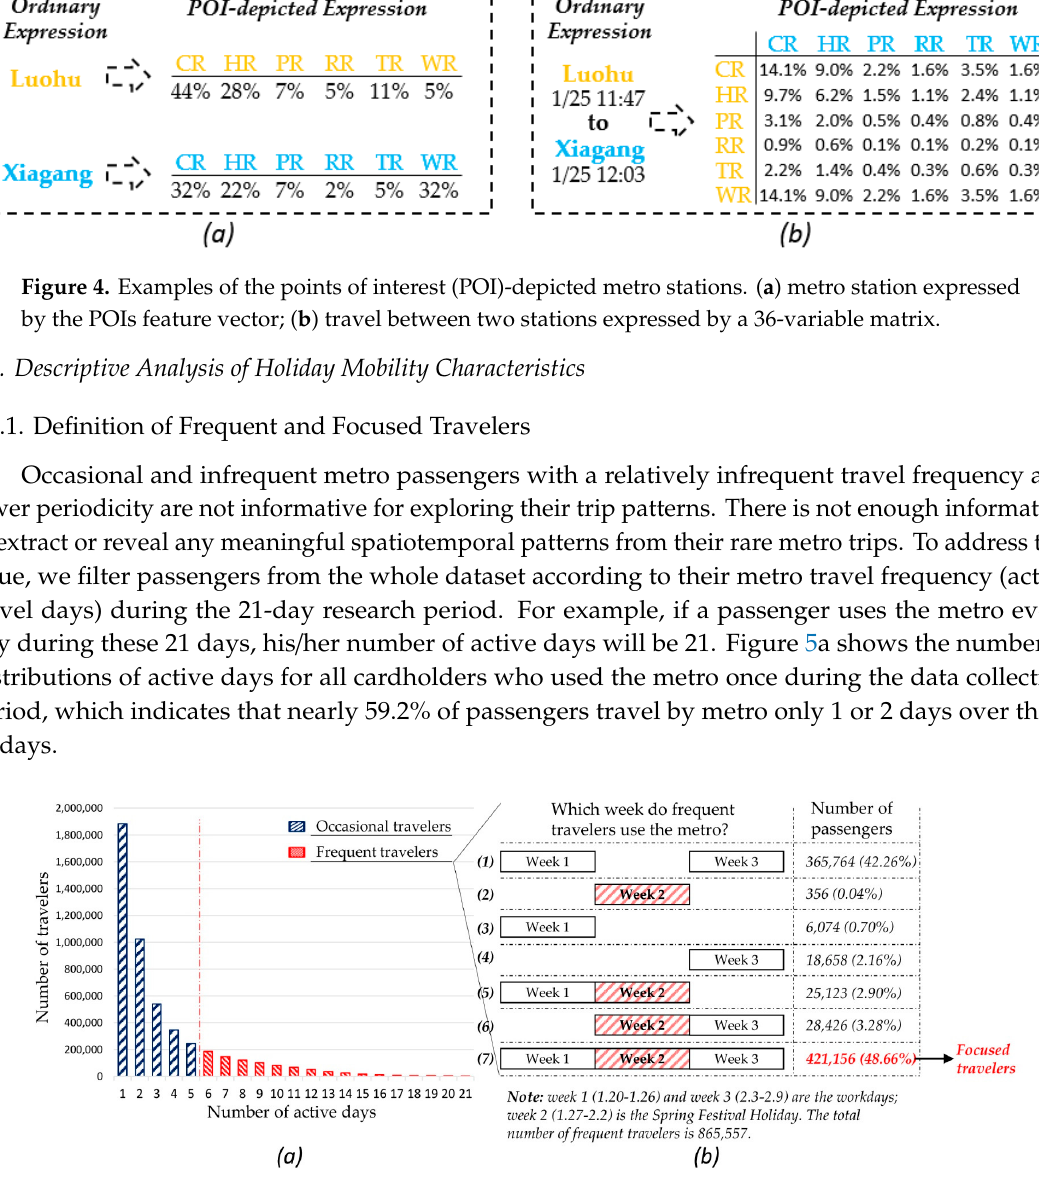
Figure 5. Distribution of active days and 7 types of frequent travelers. ( a ) Filter frequent travelers from all metro passengers; ( b ) among the selected frequent travelers, further filter the focused travelers who use the subway at least one time of each week.